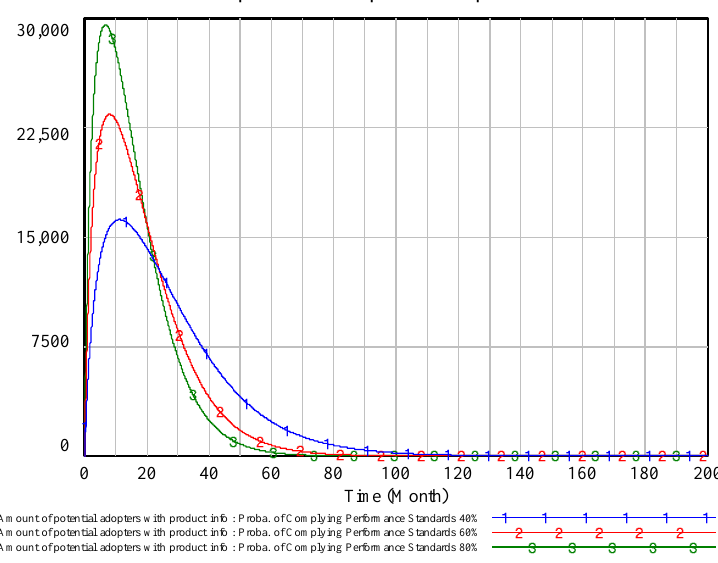
Figure 10. Sensitivity of probability of complying with performance standards on number of potential adopters with product info.